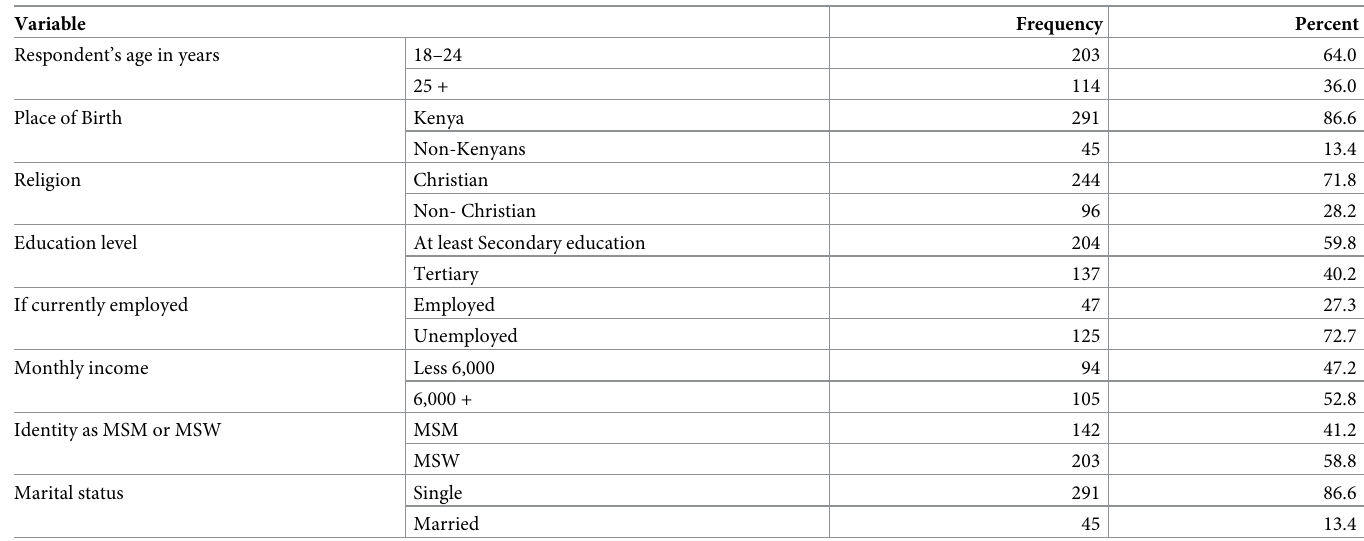
Table 1. Respondent demographic & social economic